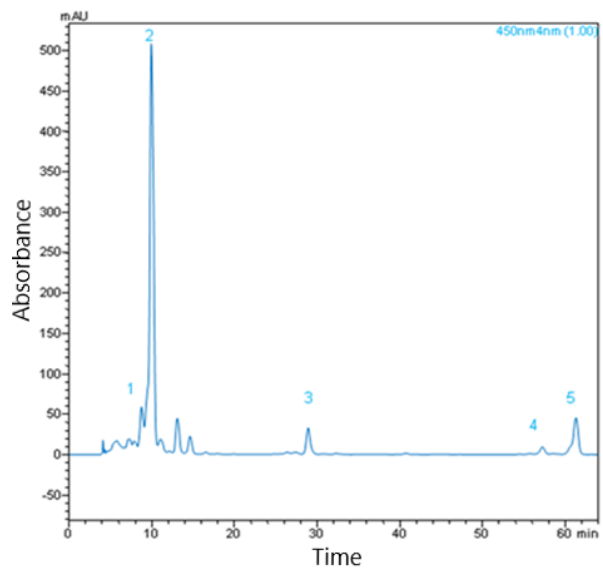
Figure 3. HPLC chromatogram of carotenoids in saponified profile illustrating the separation of carotenoids for the unsaponified extract from Carmen variety sea buckthorn berries. Peak 1—lutein, Peak 2—zeaxanthiyn, Peak 3—β-Cryptoxanthin, Peak 4— cis -β-Carotene, Peak 5—β-Carotene